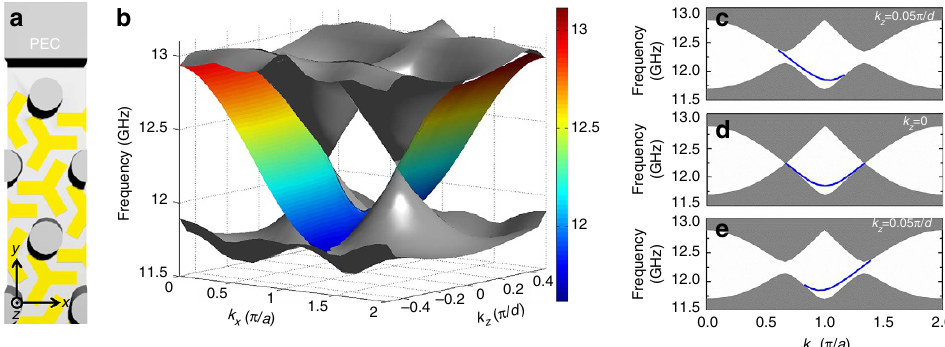
Figure 5 | Surface dispersion between the Weyl photonic crystal and the PEC. ( a ) Configuration of the Weyl photonic crystal bounded by a PEC slab. ( b ) Calculated surface dispersion in the surface Brillouin zone. For clarity, only half of the Brillouin zone ( k z A [ (cid:2) 0.5 p / d ,0.5 p / d ]) is plotted. Projected bulk states are plotted in grey, while the surface states are plotted in colour. The two linear cones of bulk states lying at the k z ¼ 0 line are due to the two Weyl points at K and K 0 (where the 5th and 6th bands intersect) with a topological charge of (cid:2) 1. The two Weyl points at H and H 0 with a charge of þ 1, which lie at the k z ¼ p line, are not shown. ( c – e ) Surface dispersions at k z ¼ (cid:2) 0.05 p / d , k z ¼ 0 and k z ¼ 0.05 p / d , respectively, where the blue lines denote the surface states.